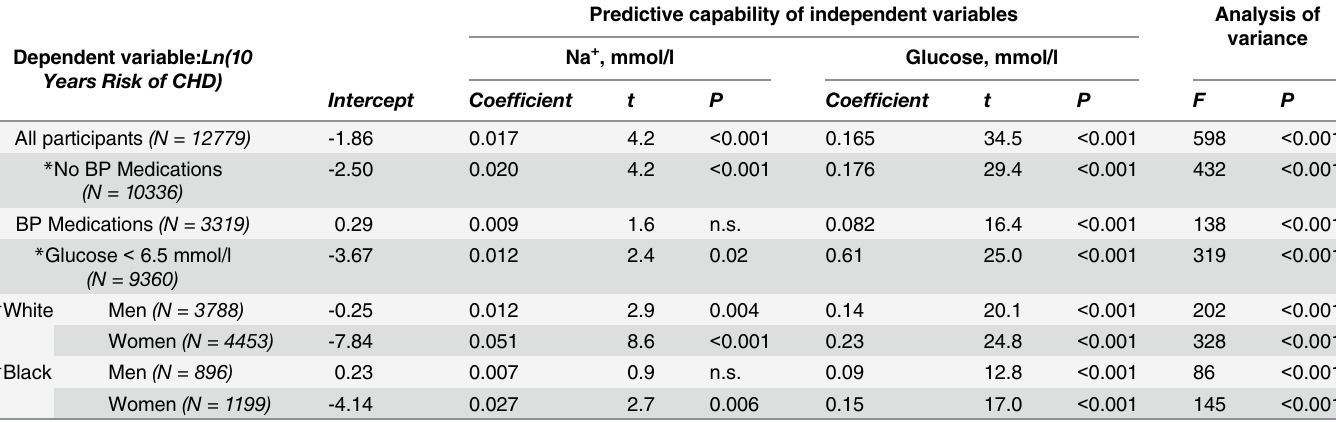
Serum Na + and glucose are signi fi cant predictors of the 10 Years Risk of CHD when all study participants are included in analysis and in the